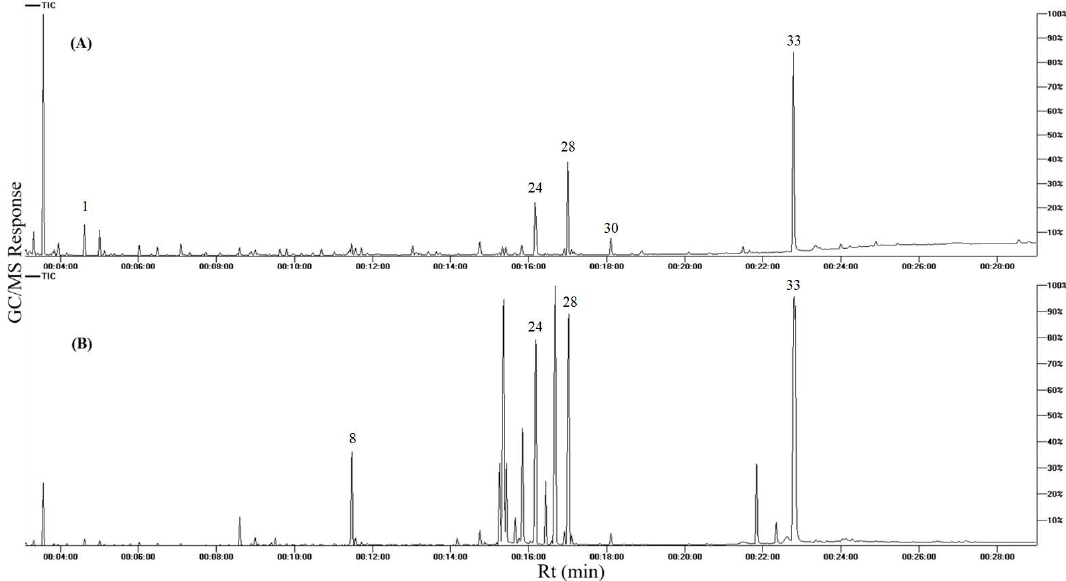
Figure 1. GC/MS chromatogram of silylated metabolites in apricot seed kernels ( A ) and fruits ( B ). The corresponding metabolite names for each peak follow that listed in Table